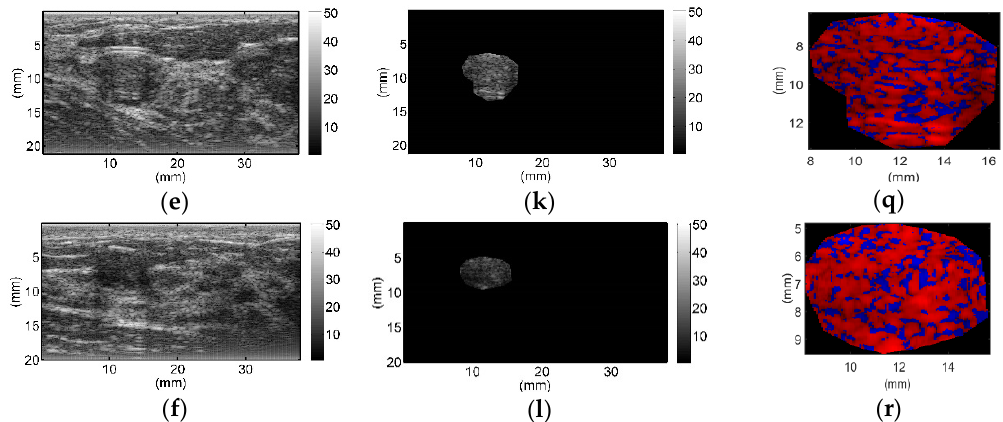
Figure 3. Typical B-mode ( a – f ), region of interest ( g – l ), and H-scan ( m – r ) ultrasound images of benign breast tumors. H-scan images ( m – r ) correspond to the regions of interest of B-mode images ( g – l ).